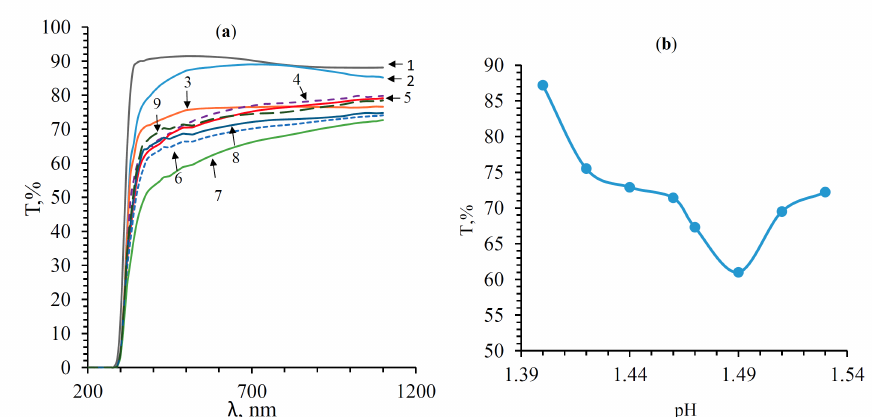
Figure 11. Transmission spectra of tin oxide thin films. ( a ) Transmission spectra: (1) the glass substrate; (2) pH = 1.40; (3) pH = 1.42; (4) pH = 1.44; (5) pH = 1.46; (6) pH = 1.47; (7) pH = 1.49; (8) pH = 1.51; (9) pH = 1.53. ( b ) Dependence of the transmittance in the visible range (400–700 nm) on